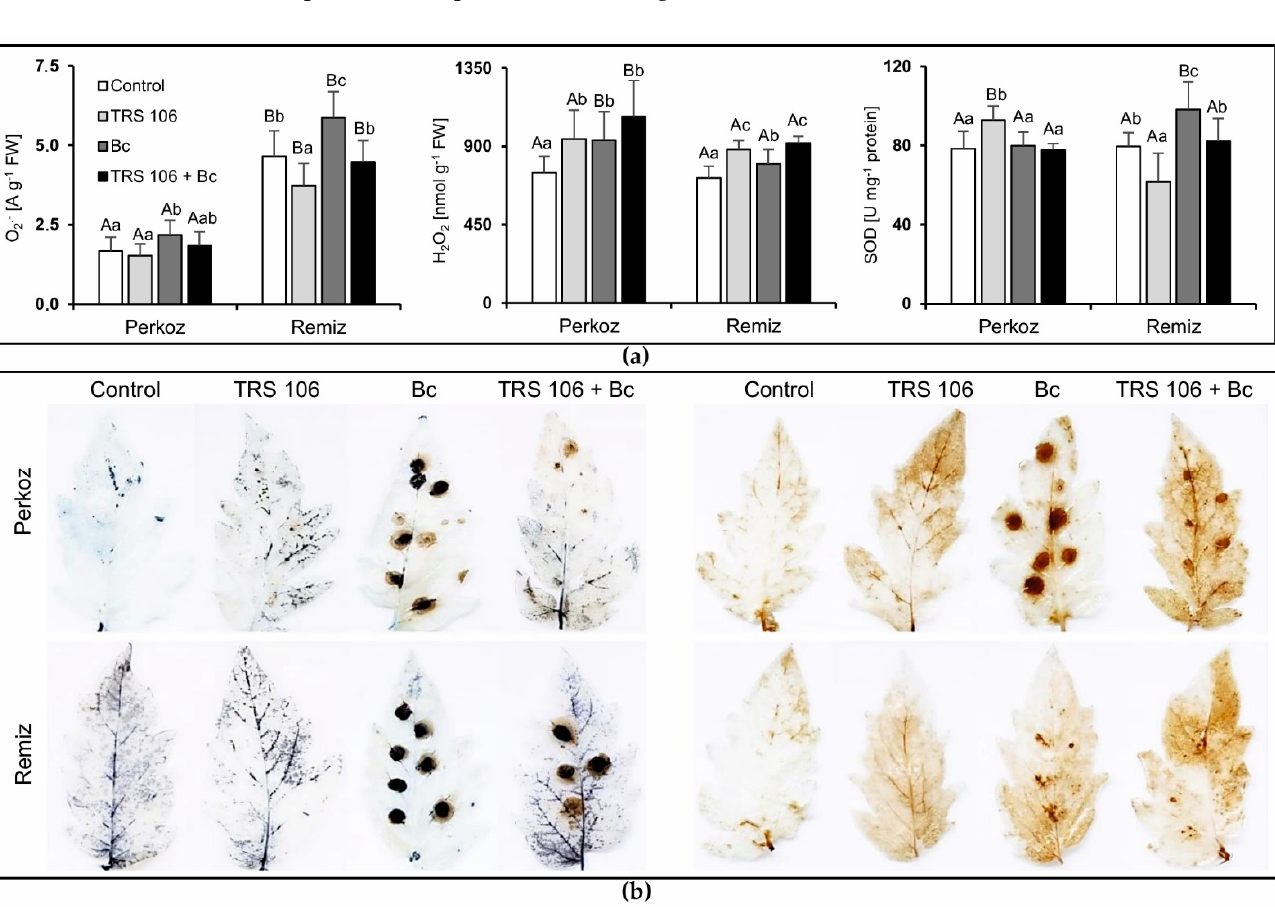
Figure 3. Effect of TRS 106 on superoxide (O 2 − ) and hydrogen peroxide (H 2 O 2 ) content, and superoxide dismutase (SOD) activity in tomato plants ( a ). Values represent the means + SE from four independent experiments with three replicates each (n = 12). Separately for each parameter, differences between varieties within a given variant were analyzed with Student’s t -test and marked using letters A and B. Separately for each cultivation, differences between all variants were analyzed with one-way ANOVA ( p < 0.05) with Tukey multiple range post hoc test. Data points followed by a different letter are significantly different at p ≤ 0.05. Under the graphs, there are histochemical visualizations of compounds prepared with NBT for O 2 − detection (blue blotches, left side of the image) and with DAB for H 2 O 2 detection (brown blotches, right side of the image) ( b ). Abbreviations are as in Figure 1.